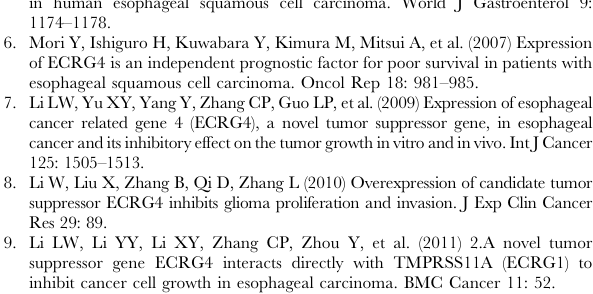
Figure S1 mRNA expression of ECRG4 in each data set, and in the pooled data set. Box plots of ECRG4 expression are shown for each data set. Expression values are NB-centered. The horizontal black line represents the level of expression of ECRG4 in the NB sample. For each box plot, median and ranges are indicated. IPC, Institut Paoli Calmettes, UNC, University of North Carolina; n, number of samples analyzed. No significant difference was observed between the different distributions (Anova, p . 0.05). (PPT) Table S1 Description of the breast cancer data sets (XLS) Table S2 Canonical pathways associated with ECRG4 expression (XLS)